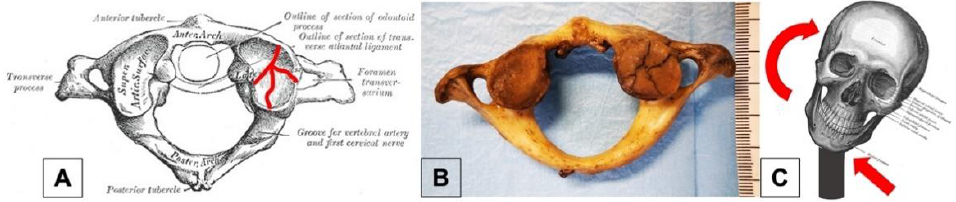
Figure 2. Right lateral mass fracture of C1 ( A ) in our case ( B ); schematic illustration of productive mechanism ( C ). Pictures A and C were adapted from Anatomy of the Human Body by Henry Gray, PHILADELPHIA: LEA & FEBIGER, 1918.